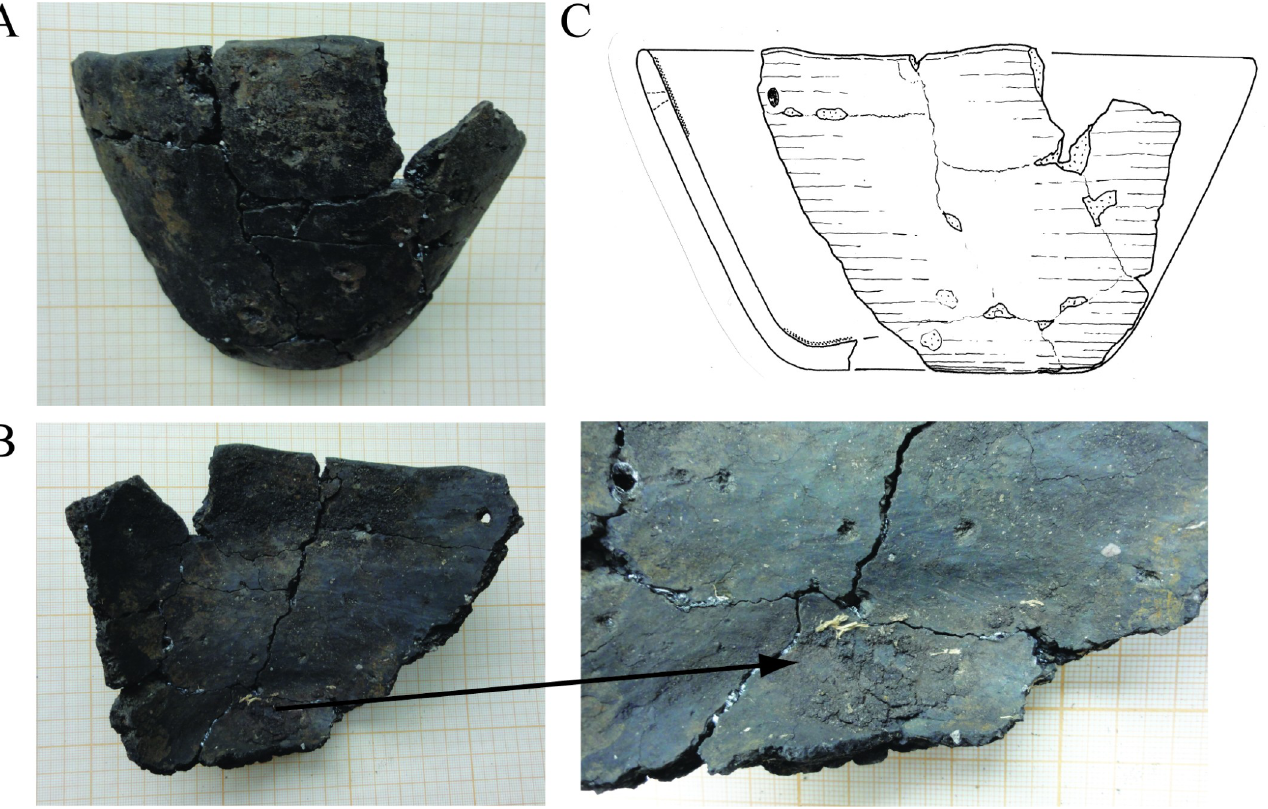
Fig 2. Fragment of Endmesolithic pottery #1977:7/3258 T from Friesack 4. Panel A: side view; Panel B: inner view, secondary conical puncture is seen at the upper right corner. Panel on the right shows basal fragment of the dish with foodcrust. Panel C: Graphical reconstruction of the profile of the bowl #1977:7/3258